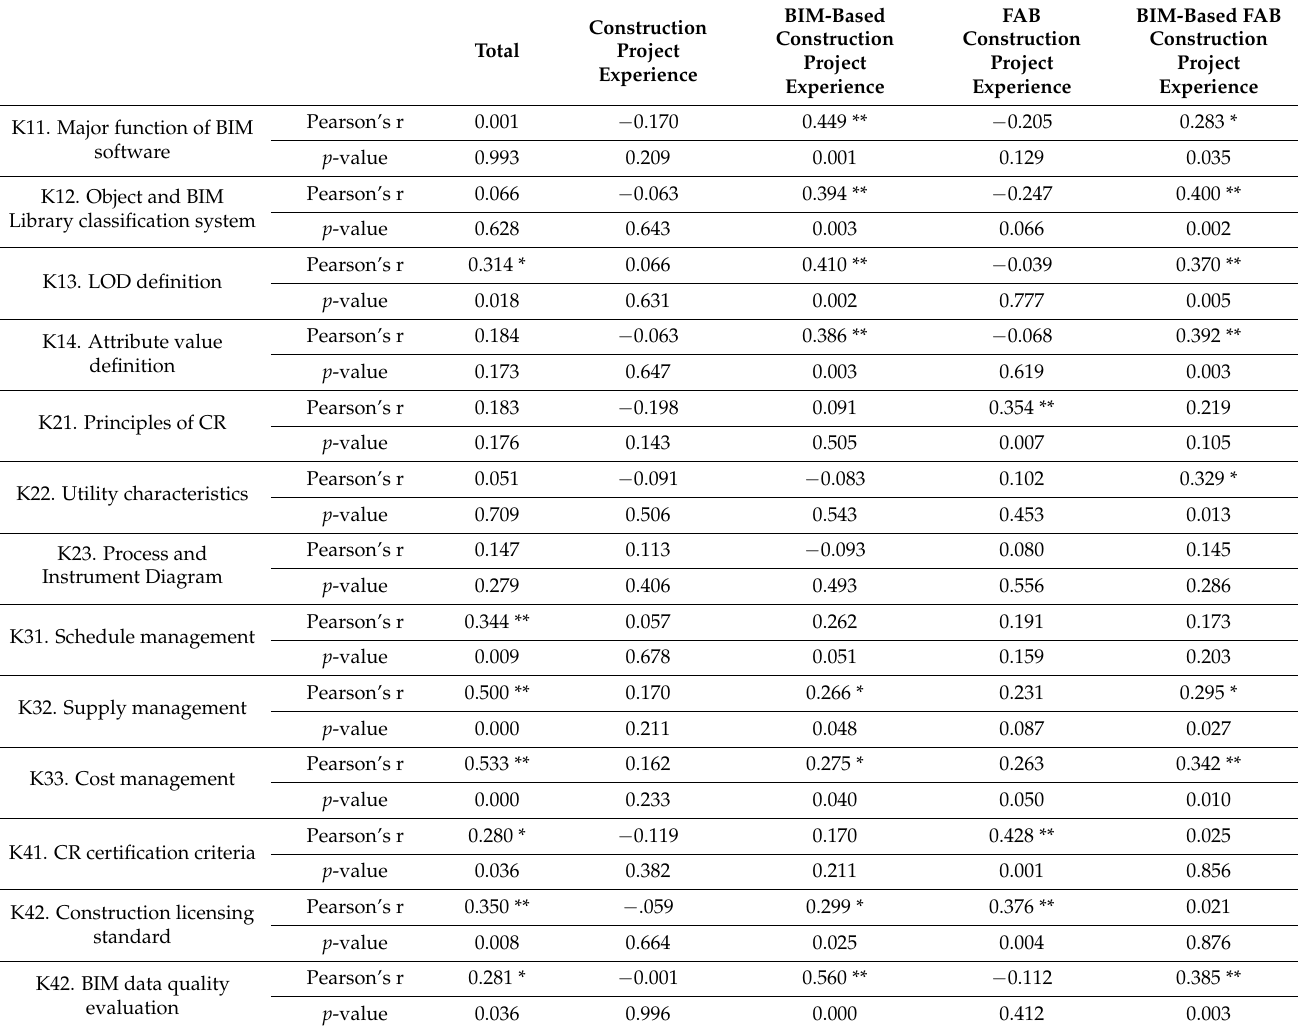
Table 8. Analysis of correlation between ‘Knowledge’ domain competencies and career characteristics of the designer